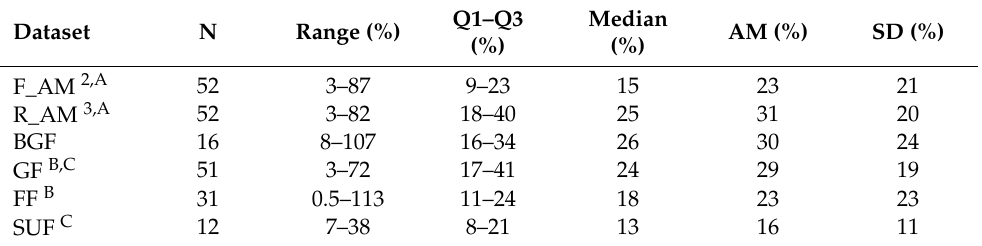
Table 4. Descriptive statistics 1 of CVs per buildings and floor. Data sets share the same uppercase letter in apex if the corresponding distributions of CVs value have statistically significant differences ( p ≤